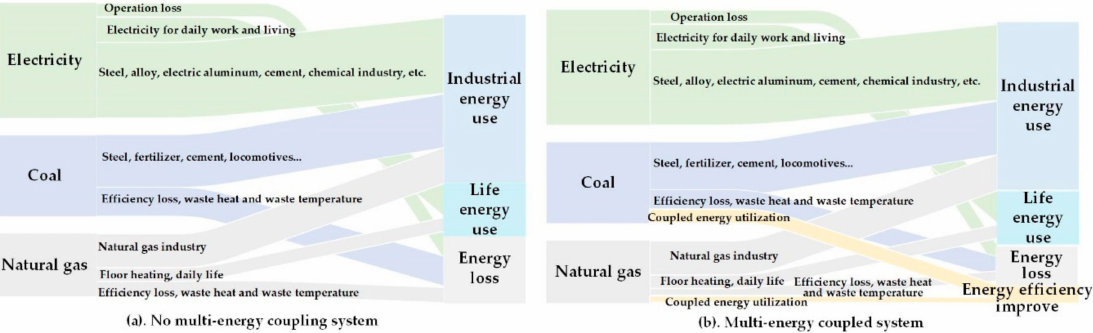
Figure 3. Energy flow comparison diagram of high energy consuming enterprises. ( a ) No multi-energy coupling system; ( b ) Multi-energy coupled